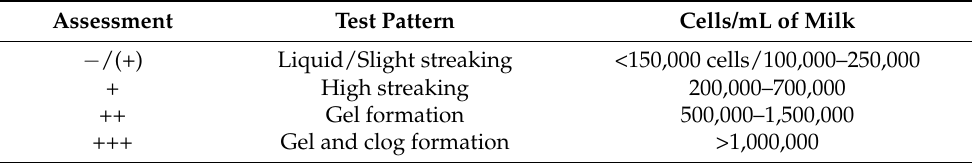
Table 4. Assessment key for indirect cell count determination using the California mastitis test [21].